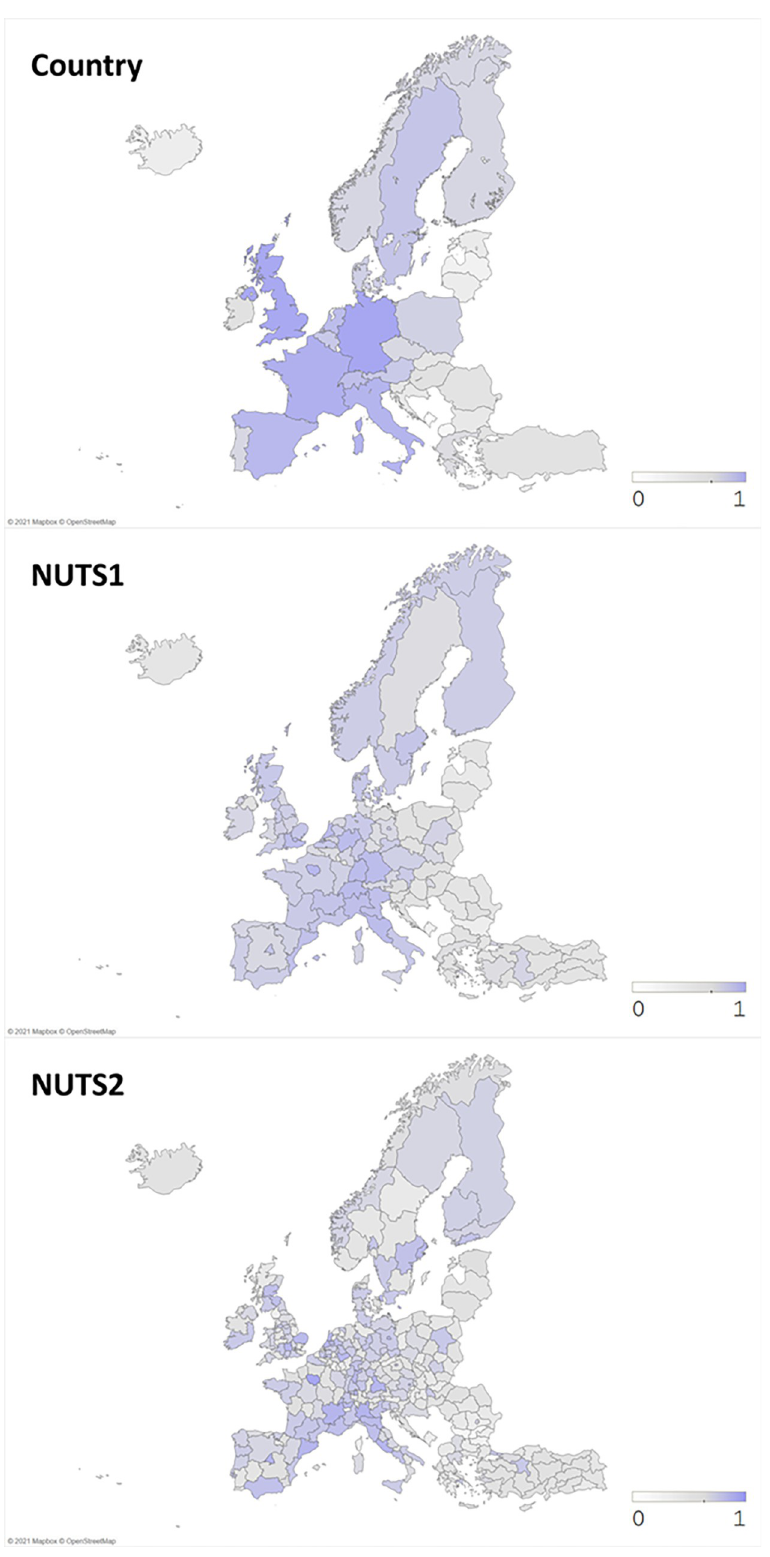
Fig 2. Number of scientific collaborations (in normalized log scale). Source: Authors’ illustration.